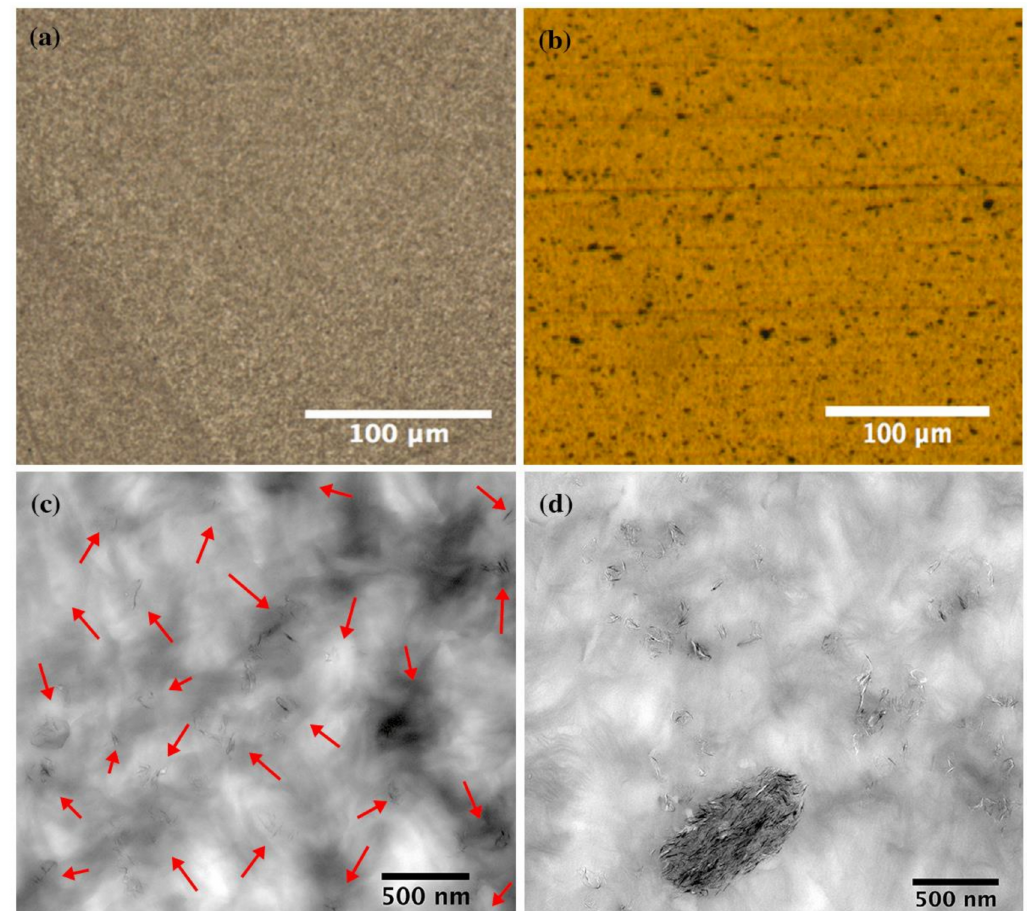
Figure 3. ( a , b ) Light microscopy images and ( c , d ) TEM images show the dispersion and distribution of 1 wt.% loading of graphene platelets within the multimodal-HDPE matrix (PE-g-1%). Images for the similar nanocomposite produced by a pre-existing processing protocol ( right ), were compared with PE-g-1% produced in this study ( left ). The TEM and light microscopy images were taken at 10k and 20x,